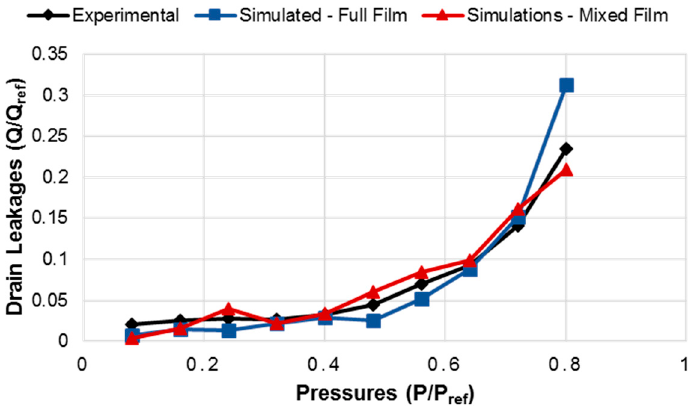
Figure 15. Comparison of measured drain leakages with the simulated ones from the full and mixed film models at an operating speed of 1000 film models at an operating speed of 1000 rpm.